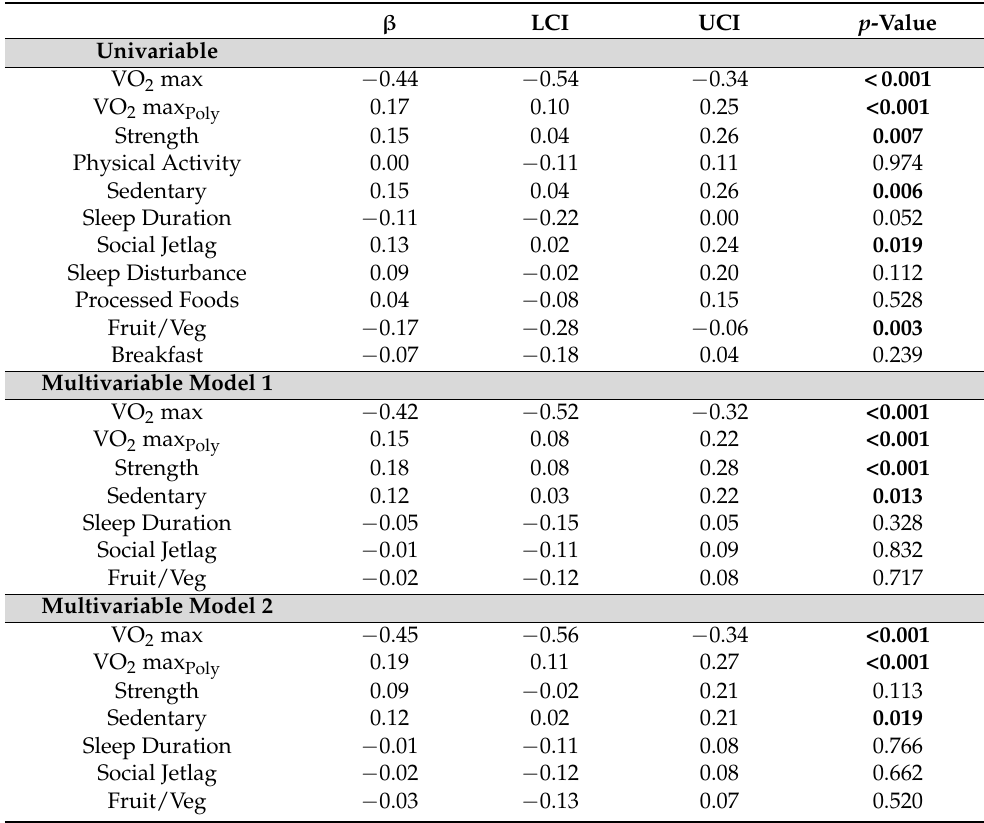
Table 3. Associations between lifestyle factors and CMD risk.